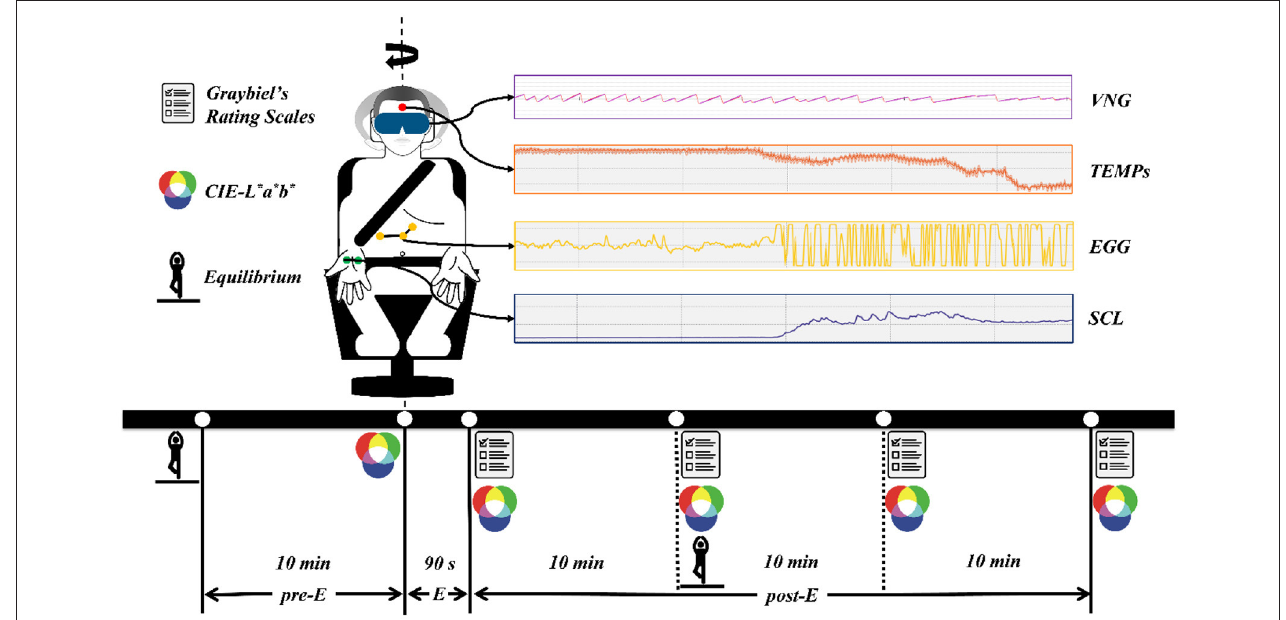
FIGURE 1 | The experimental procedure and data acquisition methods. pre-E, the period before exposure to Coriolis acceleration stimulation; E, the period of exposure to Coriolis acceleration stimulation; post-E, the period after exposure to Coriolis acceleration stimulation.